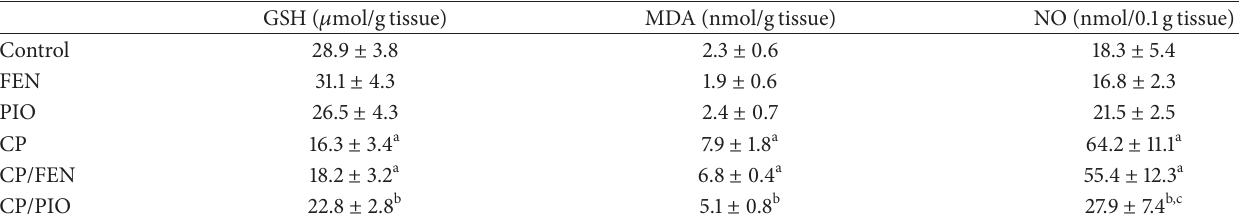
Table 3: Effect of fenofibrate (FEN) and pioglitazone (PIO) on hepatic tissue reduced glutathione (GSH), malondialdehyde (MDA), and nitric oxide (NO) levels in cyclophosphamide (CP)-treated